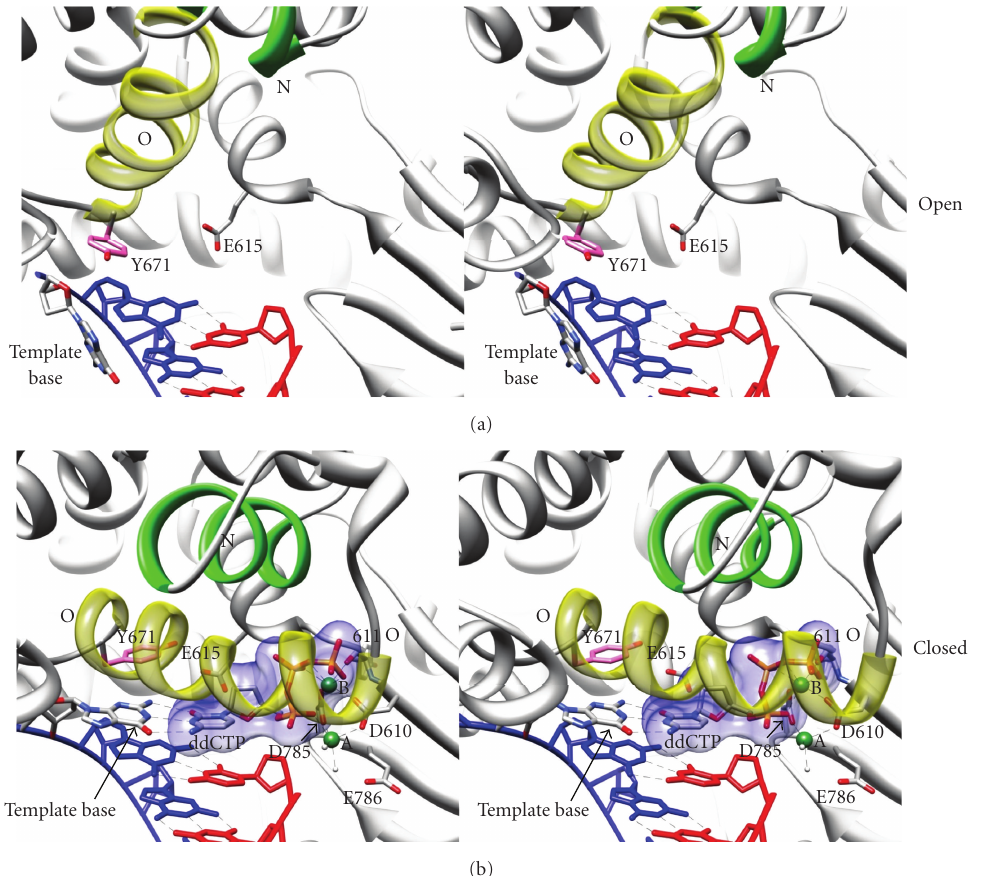
Figure 2: Stereoview (cross-eyed viewing) of Klentaq1 active site in the open binary (a) (PDB #4KTQ) and closed ternary (b) (PDB #3KTQ) conformations from the same view point [8]. (a) Open conformation: The O (yellow) an N (green) helices are in an open conformation allowing incoming dNTPs to reach the active site. The templating base (colored by element) is flipped out and Y671 (pink) occupies a stacked arrangement with the template (dark blue). (b) Closed conformation: The O and N helices have undergone a large conformational change and closed o ff the nucleotide binding pocket, which a ddCTP (colored by element with blue space filling) now occupies. The Y671 residue has flipped away from the template allowing the templating base to form a Watson-Crick base-pair with the ddCTP. The position of E615 allows screening of rNTPs via a steric clash with what would be a 2 (cid:2) OH of an incoming rNTP. The metal ions A and B (green spheres) form interactions with the phosphates of the ddCTP, and Klentaq residues D610, 611 O, D785, and 2 waters (grey spheres). The missing binding partner of metal A is hypothesised to be the missing 3 (cid:2) OH of the dideoxy-terminated primer